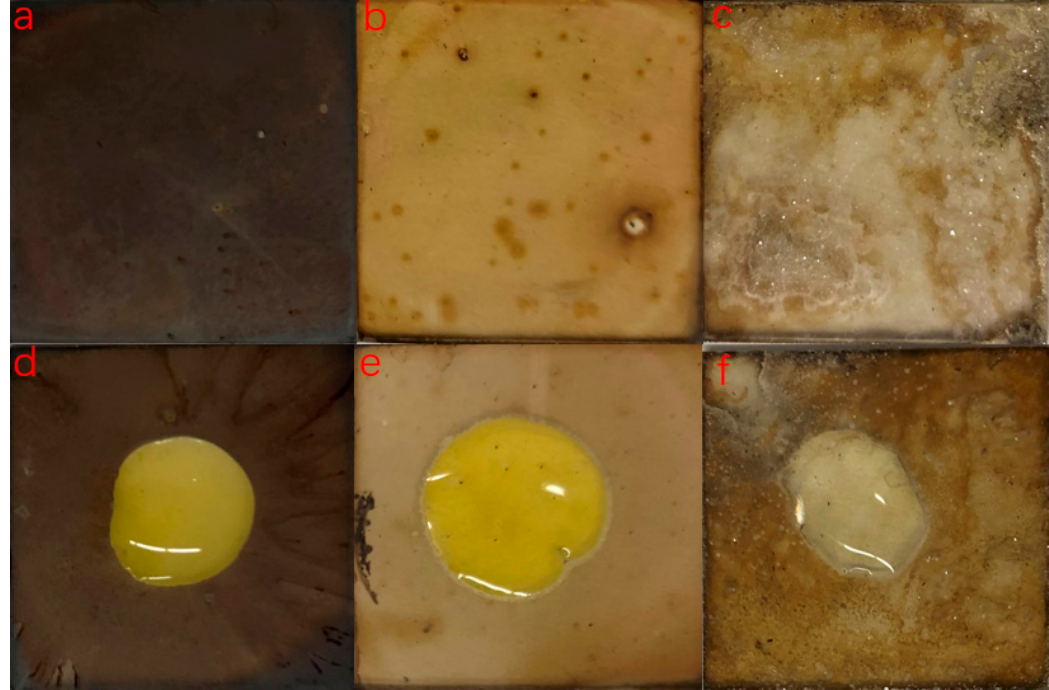
Figure 2. Water-induced degradation experiments(( a ), ( b ), ( c ) are the original images of sample A, B and C before introducing water; ( d ), ( e ), ( f ) are the water-contact results of sample A, B, C after 1 s, 10 s, 60 mins) .